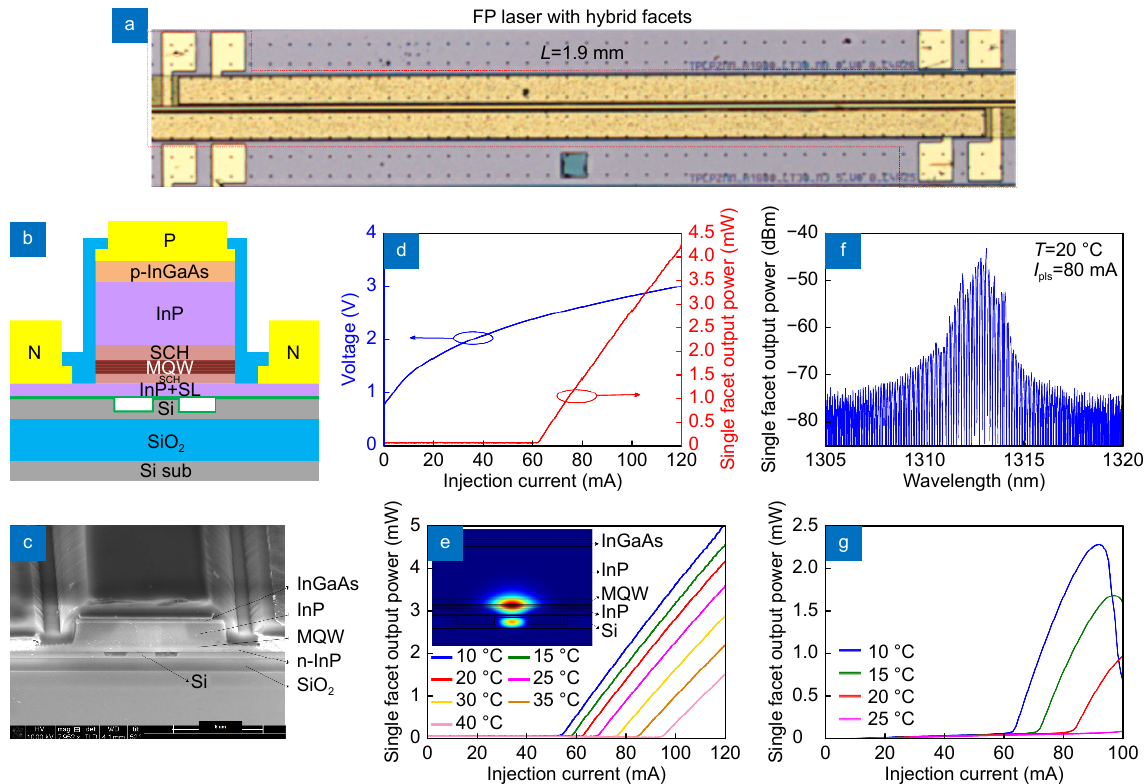
Fig. 9 | ( a ) A microscope image of a FP laser with hybrid facets. ( b ) Schematic drawing of the device cross-section and ( c ) SEM of the hybrid fa- cet. ( d ) RT pulsed LIV. ( e ) Pulsed LI up to 40 °C (inset: mode profile at facets). ( f ) Device spetrum. ( g ) cw LI up to 25 °C. Figure repoduced with permisson from ref. 29 , under a Creative Commons Attribution 4.0 International